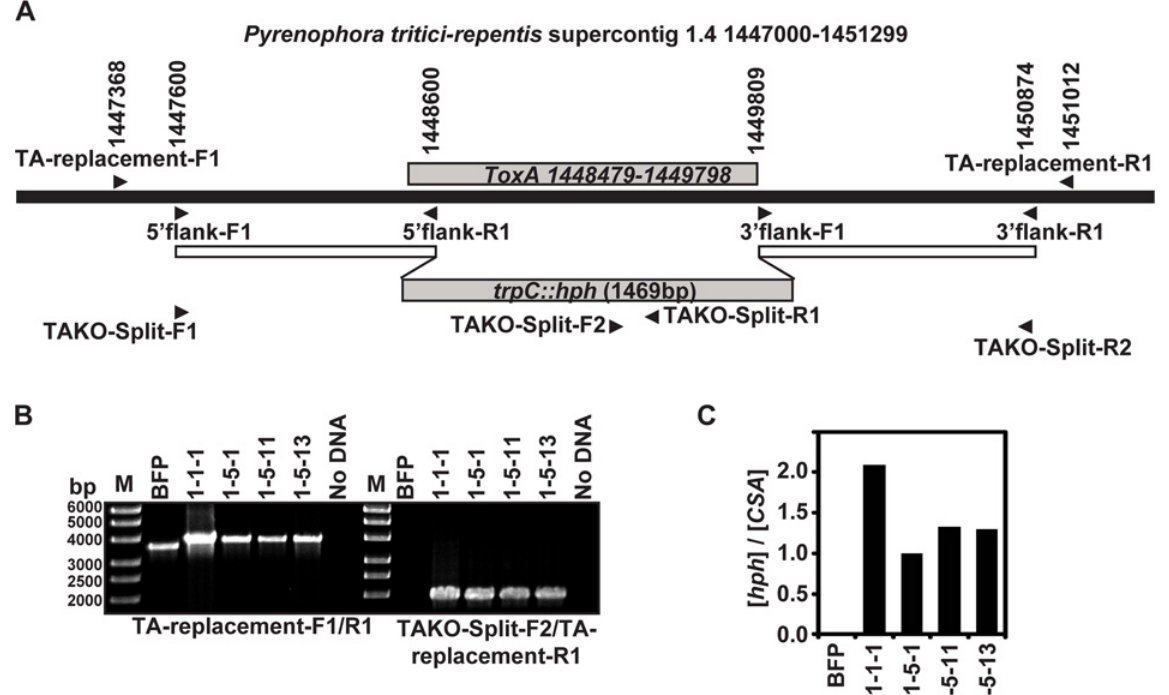
Fig 1. ToxA gene replacement with a hygromycin resistance cassette in the P . tritici-repentis isolate, BFP. (A) Schematic of the ToxA -containing genomic region of the P . tritici-repentis reference genome (top) and the gene replacement construct containing 5 ’ and 3 ’ ToxA flanking regions and the hygromycin resistance gene ( hph ) driven by the trpC promoter, trpC :: hph (bottom). Black arrowheads indicate the position of PCR primers used for cloning and positional screening and the numbers above the top schematic indicate primer sequence position on supercontig 1.4. Genomic DNA from BFP and transformants was (B) PCR amplified to test for ToxA replacement (left) and proper orientation of the trpC :: hph replacement construct (right) and (C), subjected to qPCR to predict the copy number of the trpC :: hph fragment by calculating the ratio of the concentration of hph to the concentration of the single copy gene chitin synthase A ( CSA ). The molecular mass of standards in the molecular mass ladder (M) is indicated on the left of panel B.